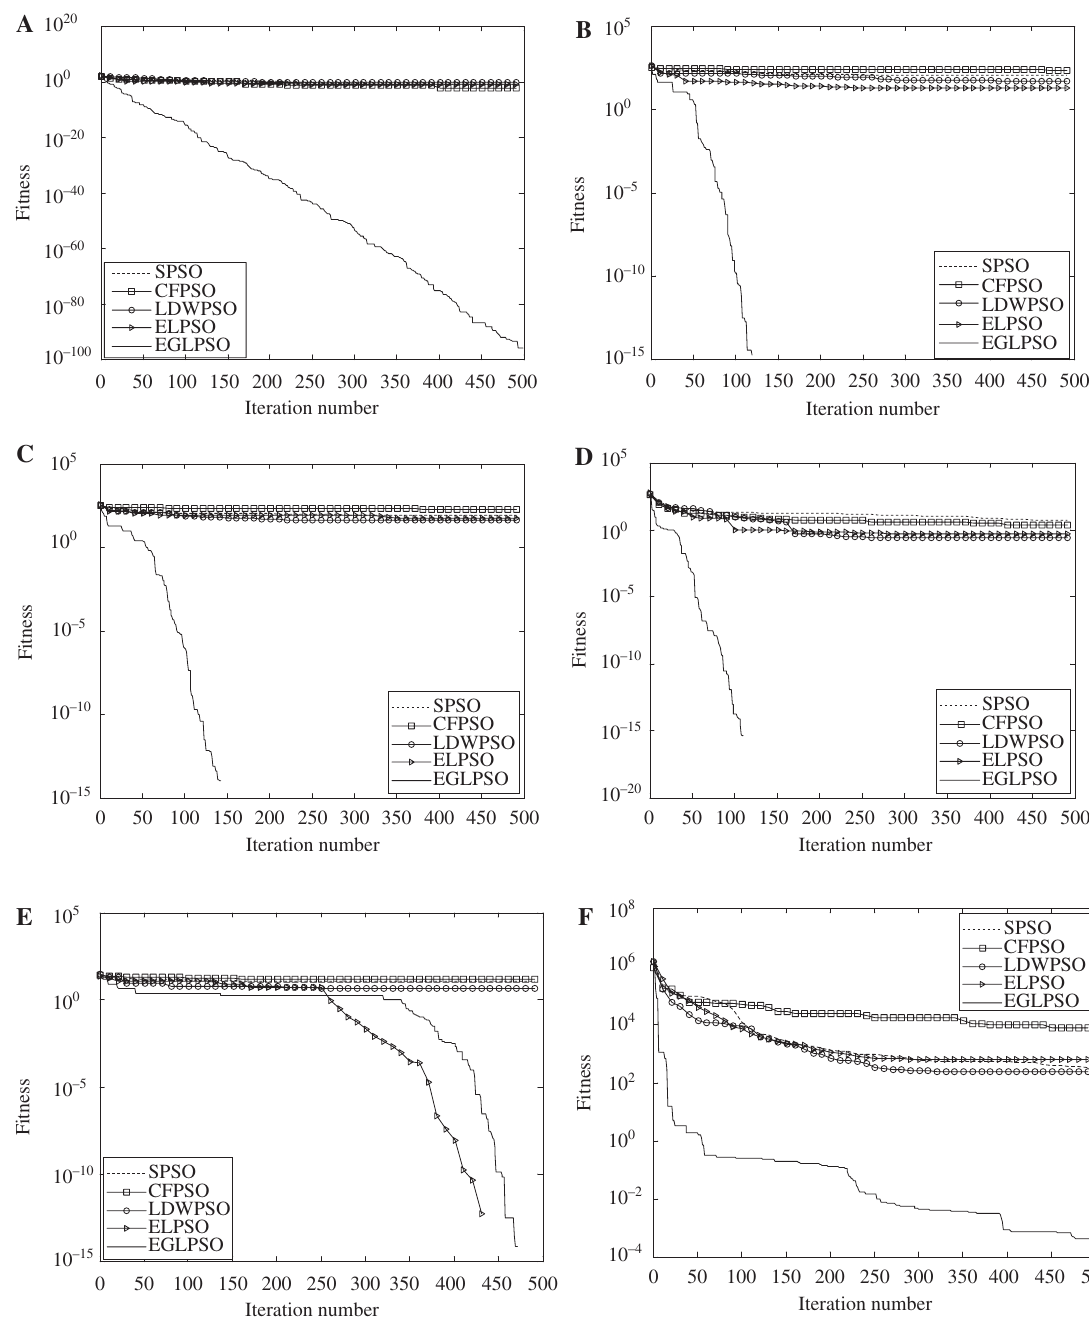
Figure 3: The Convergence Characteristics on Selected Functions ( D =